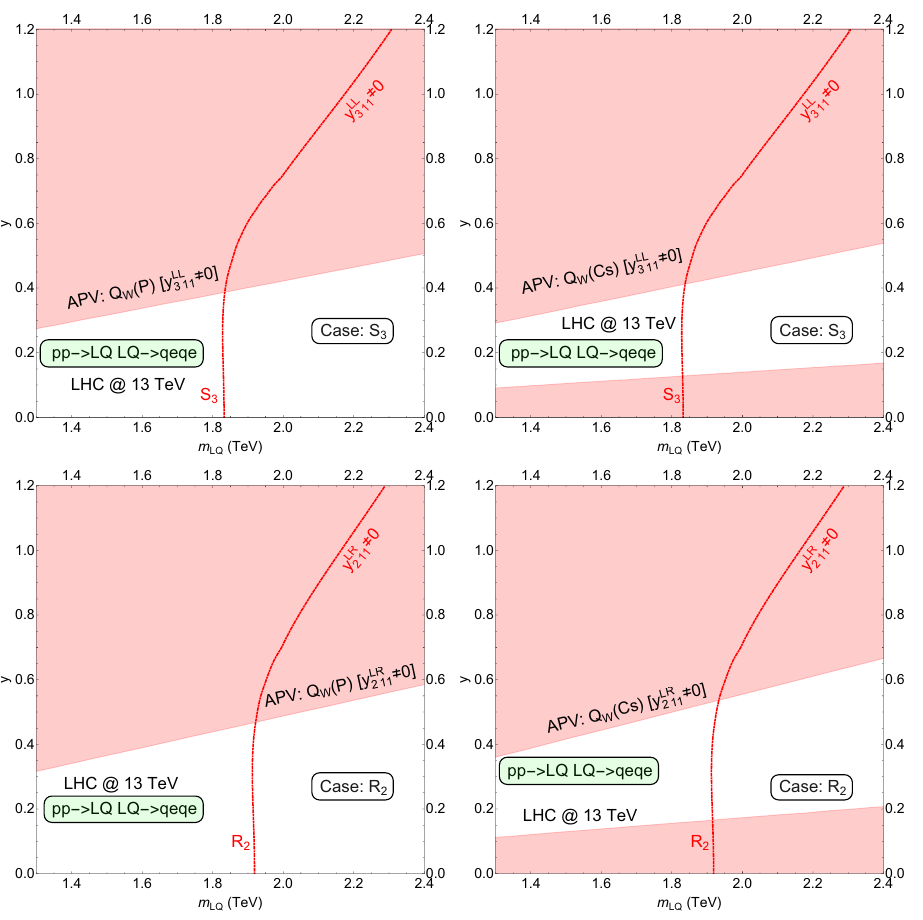
Figure 12 . APV limits for the proton (left) and Cs (right) measurements juxtaposed with the leptoquark pair production search limits for the corresponding leptoquark scenarios, as indicated. Shaded regions are ruled out by the APV